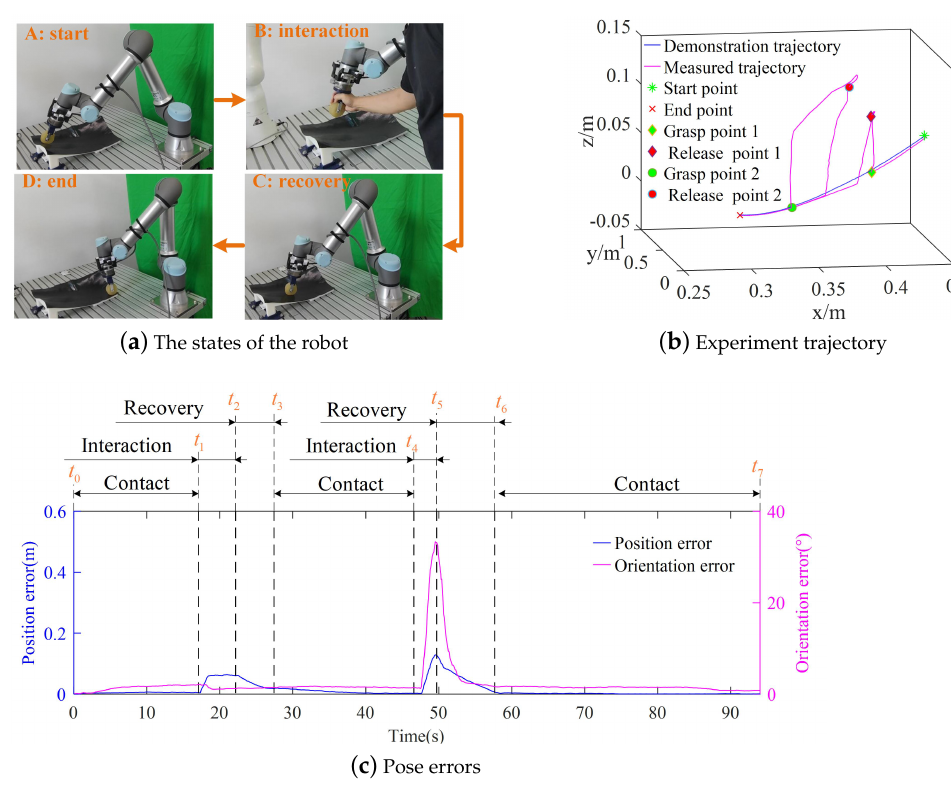
Figure 14. Experiment trajectory and pose errors of robot executing a contact task under